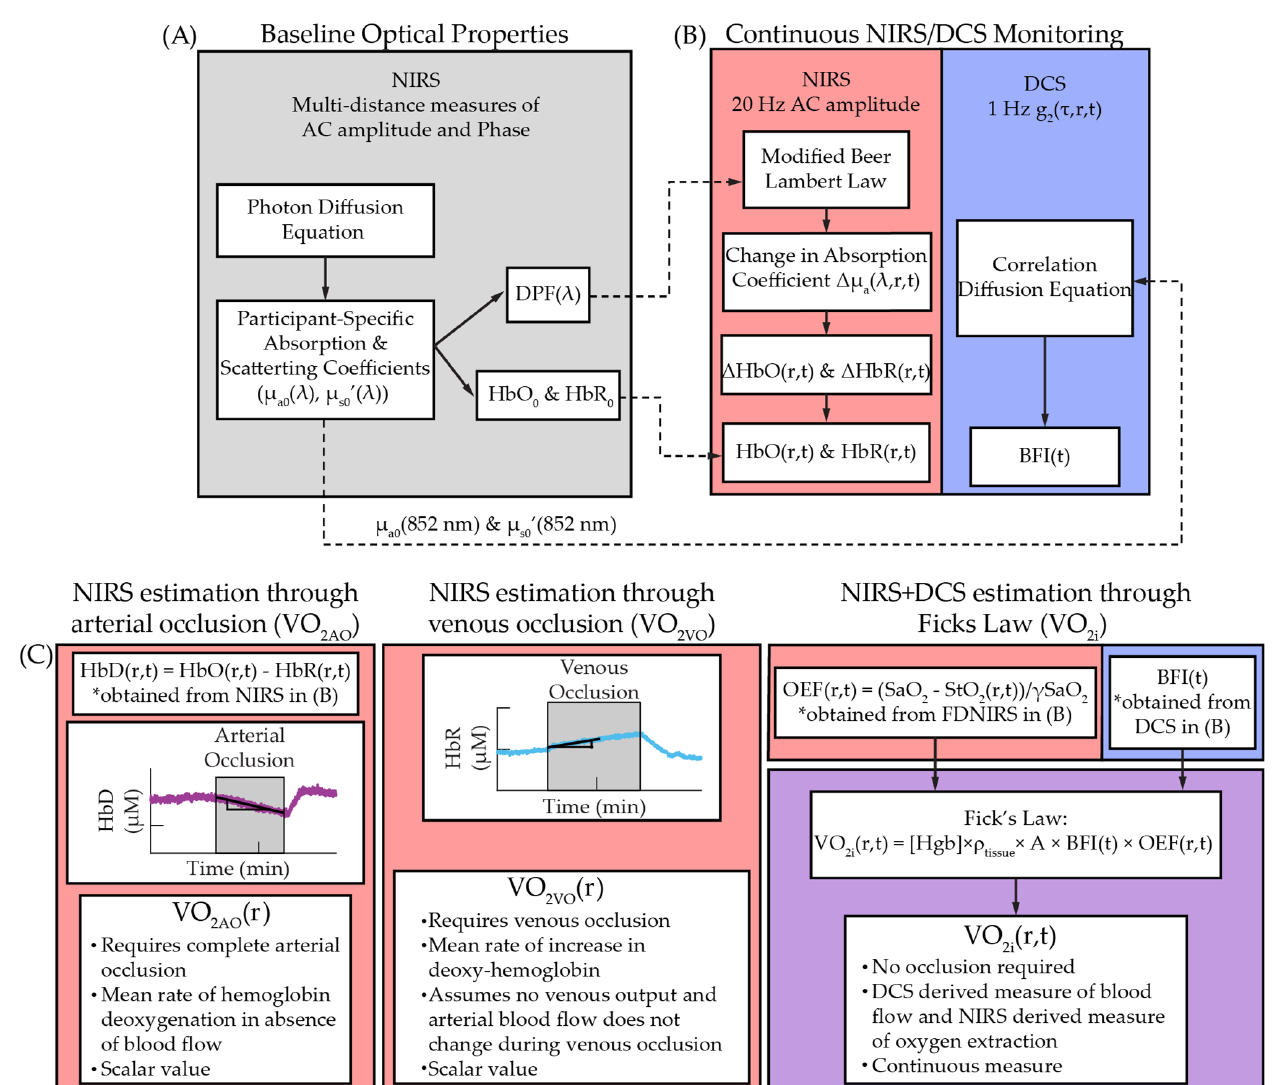
Figure 5. Data analysis pipeline. ( A ) First, wavelength-dependent optical properties ( μ a ( λ ) and μ s ’( λ )) were determined using the semi-infinite solution to the photon diffusion equation and were used to estimate baseline hemoglobin concentra- tions (HbO 0 and HbR 0 ) and the wavelength-dependent differential pathlength factor (DPF( λ )). ( B ) Next, dynamic changes in hemoglobin concentration were estimated during occlusion epochs with NIRS using the modified Beer–Lambert Law coupled with baseline variables from A (left panel, in red). Dynamic changes in blood flow index were estimated with DCS during occlusion epochs by fitting measured intensity autocorrelation curves to the semi-infinite solution of the correlation diffusion equation using baseline optical properties from A (right panel, in blue). ( C ) Finally, oxygen metabo- lism was calculated one of three ways: (1) using the mean rate of hemoglobin deoxygenation at each source-detector sep- aration, r, from B during arterial occlusion (VO 2AO (r), red box, left); (2) using the mean rate of increase in deoxyhemoglobin at each r from B during venous occlusion (VO 2VO (r), red box, middle); (3) using Fick's Law by combining NIRS measures of oxygen extraction from B (red box, left side) and DCS-derived measures of blood flow index from B (blue box, right side) to quantify an index of oxygen metabolism index (VO 2i (r,t), purple box).